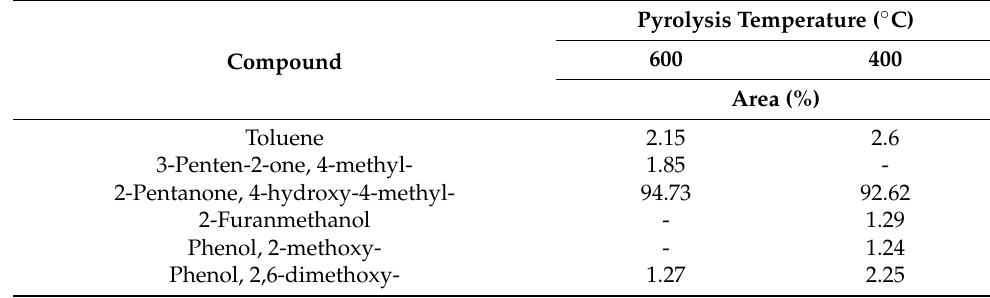
Table 5. Compounds detected in bio-oils chromatograms and their relative area percentages obtained in the pyrolysis of orange pruning at different temperatures.